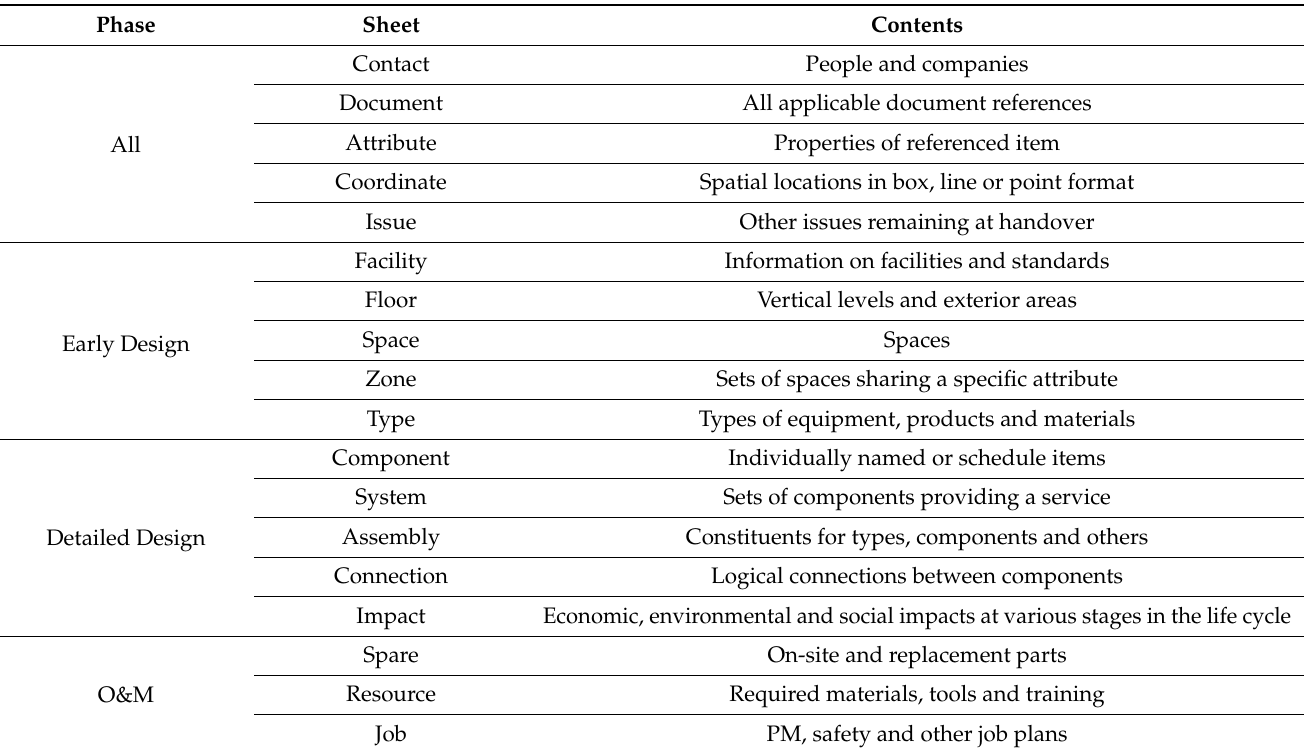
Table 1. COBie datasheets and contents for each construction